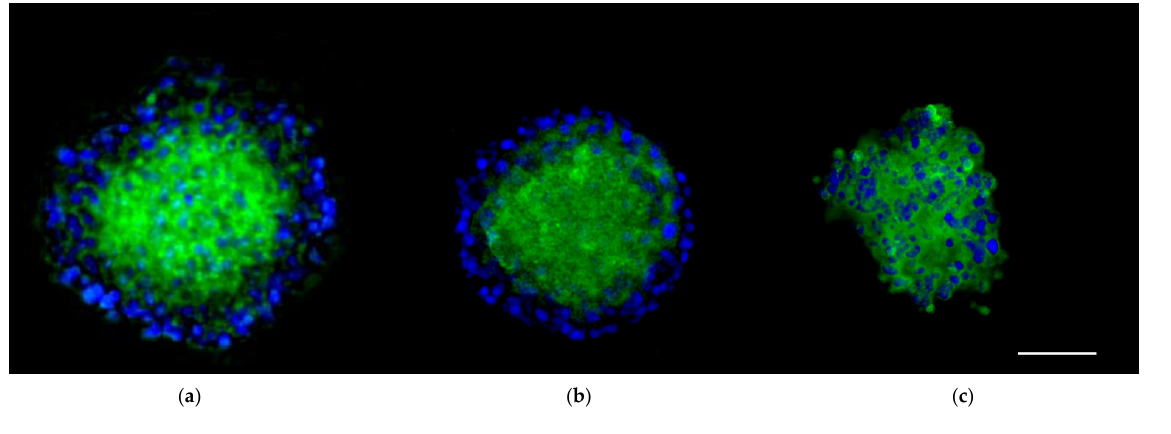
Figure 4. Representative image of spheroids obtained by culturing human neuroblastoma 3D SH- SY5Y/RA cells in the LB1 after 24 h of fluid condition (100 µL/min). Spheroids were immunoreacted with PAC1-R primary antibody (GFP, ( a )), VPAC 1 primary antibody (GFP, ( b )), VPAC 2 primary antibody (GFP, ( c )). Nuclei, DAPI. Images were acquired as Z stack with the JuLI Stage fluorescence recorder and maximum intensity projection was shown. Scale bar: 250 µm.